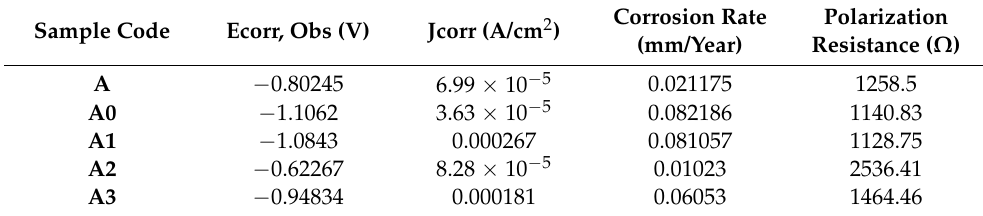
Figure 7. Linear polarization curve of Ti-Al-xNb at 1 L/min Nb gas carrier in NaCl. Table 4. Tafel results of Ti-Al-xNb LENS manufactured alloys in